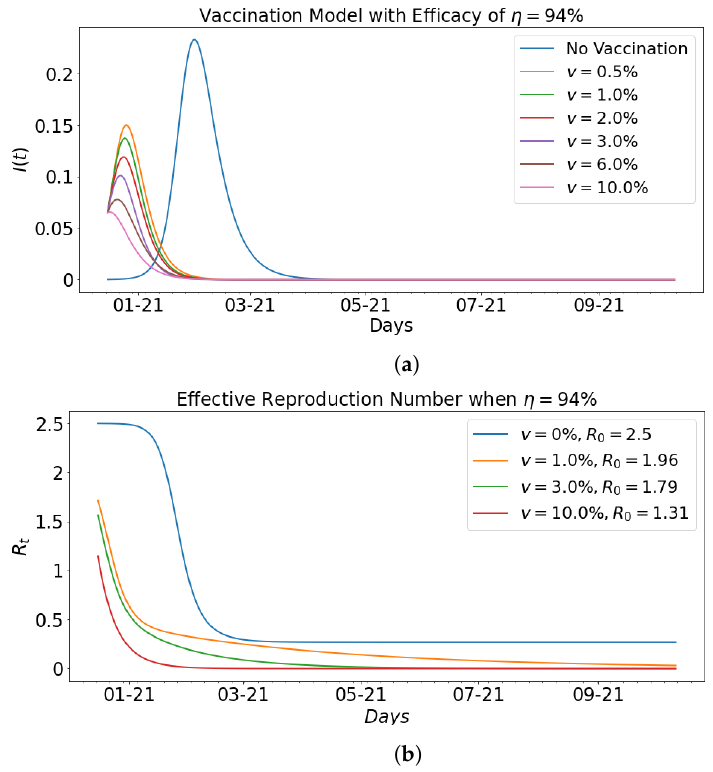
Figure 11. Vaccination model with effective reproduction number when efficacy is η = 94%; in ( a ) when the vaccination rate increases from 0% to 10%, the level of infectiousness declines; ( b ) shows the effective reproductive number for different vaccination rates v with their corresponding basic reproduction number R 0 . When v = 0%, R 0 = 2.5, and the vaccination rate increases from 0% to 3%, the R 0 decreases from R 0 = 2.5 to R 0 = 1.79. When the vaccination rate is increased further to 10%, it can be seen that the basic reproduction number reduces drastically to 1.31. Vaccination impacts the spread of the virus as seen in this figure. Table 4. Parameter